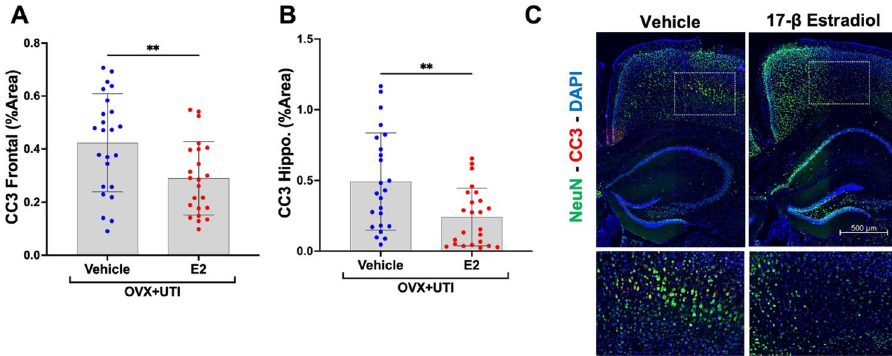
Figure 3. 17β-estradiol (E2) decreases UTI-induced cleaved caspase-3 (CC3) in the frontal cortex and hippocampus. ( A , B ) Among oophorectomized mice with UTIs (OVX + UTI), those treated with E2 (n = 24) show a statistically significant reduction in CC3 in both the frontal cortex and hippocampus as compared to vehicle (sesame oil) treated (n = 24). ( C ) Representative staining of CC3 and neuronal nuclear protein (NeuN) in both vehicle and E2 treated mice. For ( A ), a single statistical outlier was identified and removed from the E2 group. Exclusion of the data point yielded p = 0.0072 (t = 2.814, df = 45), while inclusion resulted in p = 0.0352 (t = 2.170, df = 46) (see Fig. S7a) *p < 0.05, **p < 0.01.